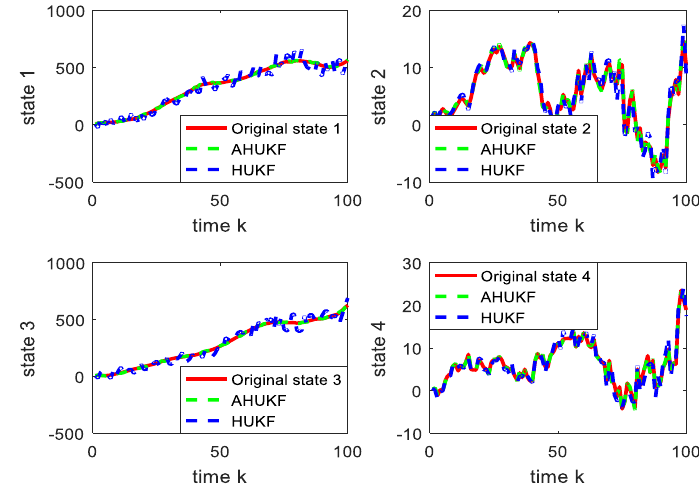
Figure 1. True trajectory and estimated trajectory for four states.